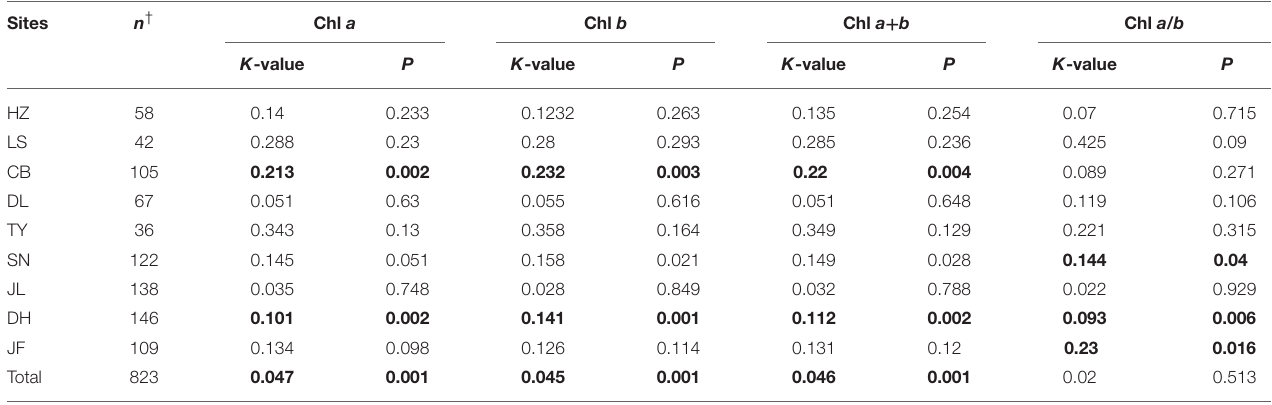
TABLE 5 | Strength of the phylogenetic signal in chlorophyll traits for each of the nine forests.